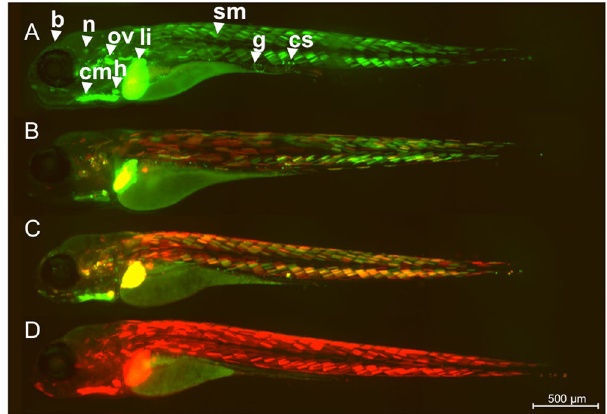
Figure 2. Kaede conversion analysis. ERE-Kaede-Casper larvae were exposed to 100 ng EE2/L over the period 0–5 dpf and imaged at 5 dpf either without UV exposure ( A ), or after exposure to UV at 3 dpf ( B ), 4 dpf ( C ) and 5 dpf ( D ) to convert Kaede fluorescence from green to red. Specific tissue response in the liver (li), heart (h), somite muscle (sm), otic vesicle (ov), cardiac muscle (cm), corpuscle of Stannius (cs), brain (b), neuromast (n), and gut